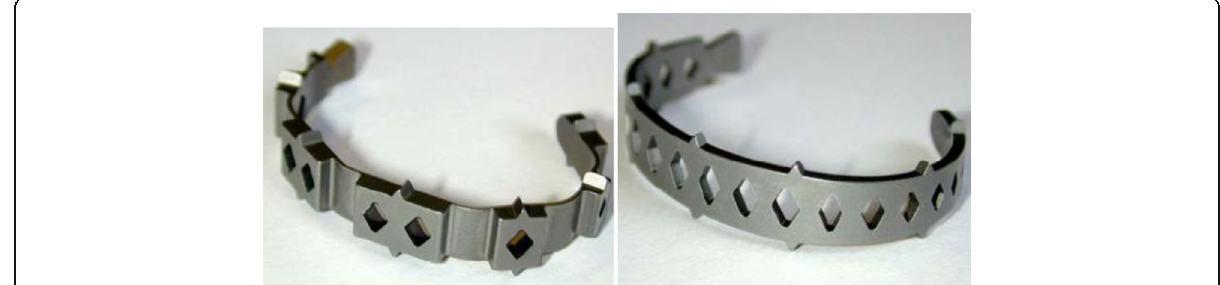
Fig. 2 The new prototype cages (left: NiTi-l, right: NiTi-s)